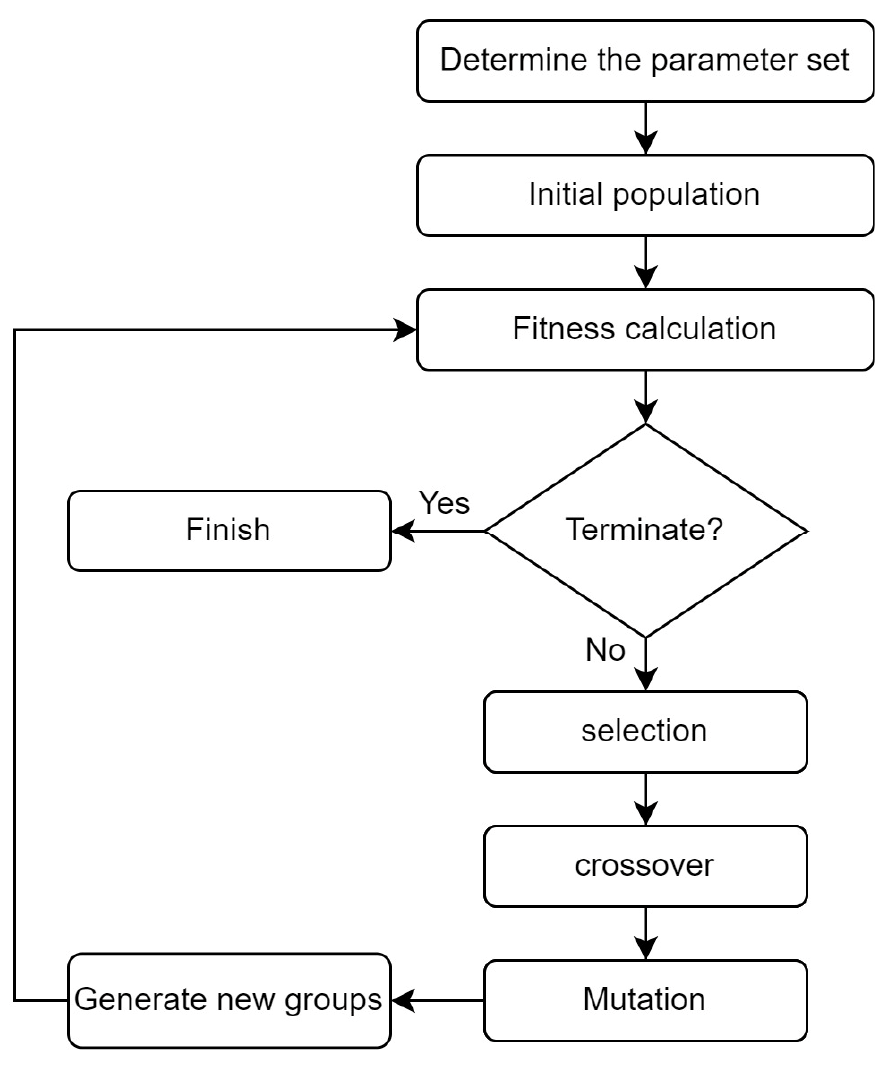
Figure 3. GA flow chart. Figure 3. GA flow Fitness function = objective function + penalty